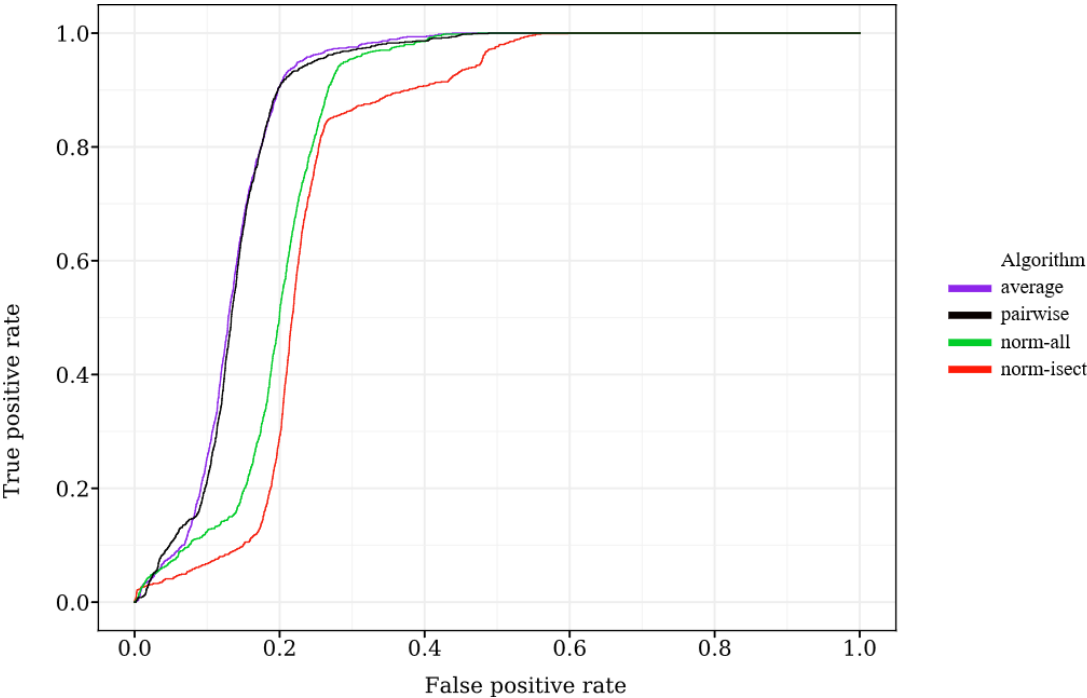
Figure 7. Global reputation table receiver operating characteristic (ROC) curve comparison on the biggest 100 networks.